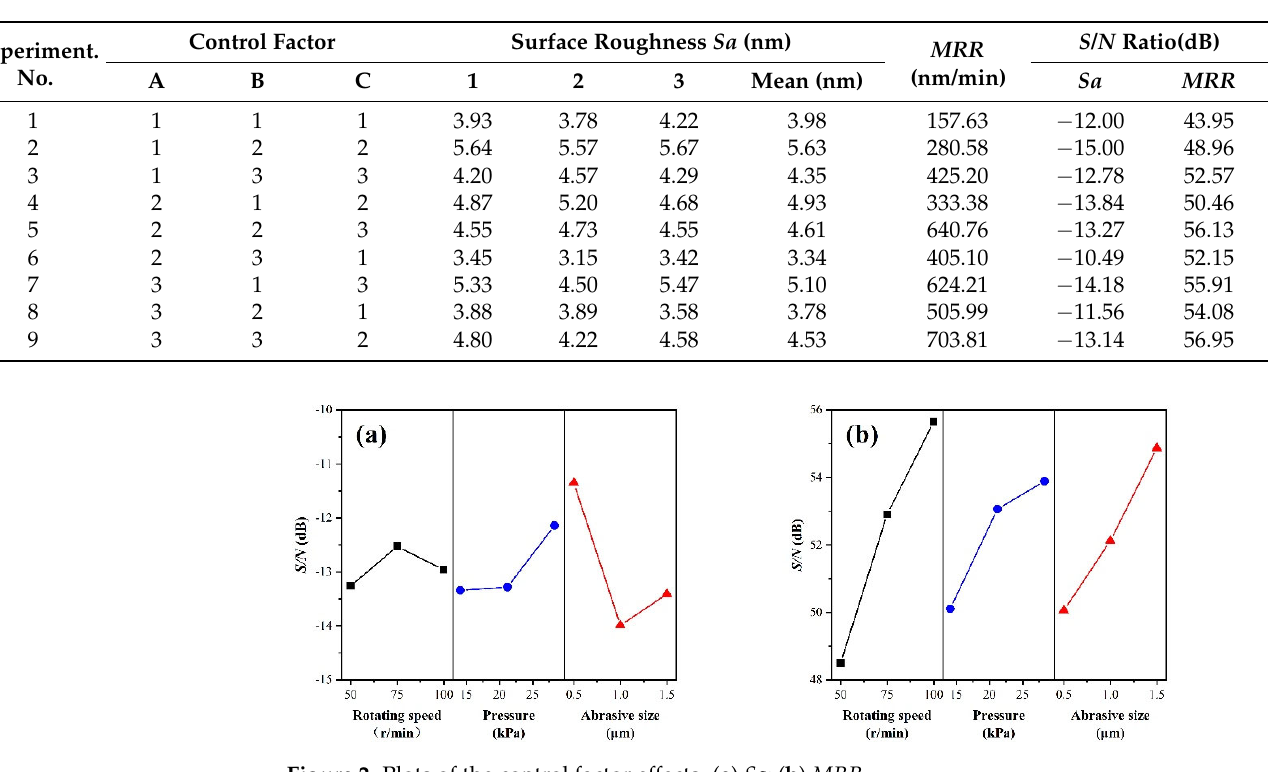
Figure 3. X ‐ ray diffraction patterns of the Zr 48 Cu 36 Ag 8 Al 8 sample before (black) and after (red) polishing.